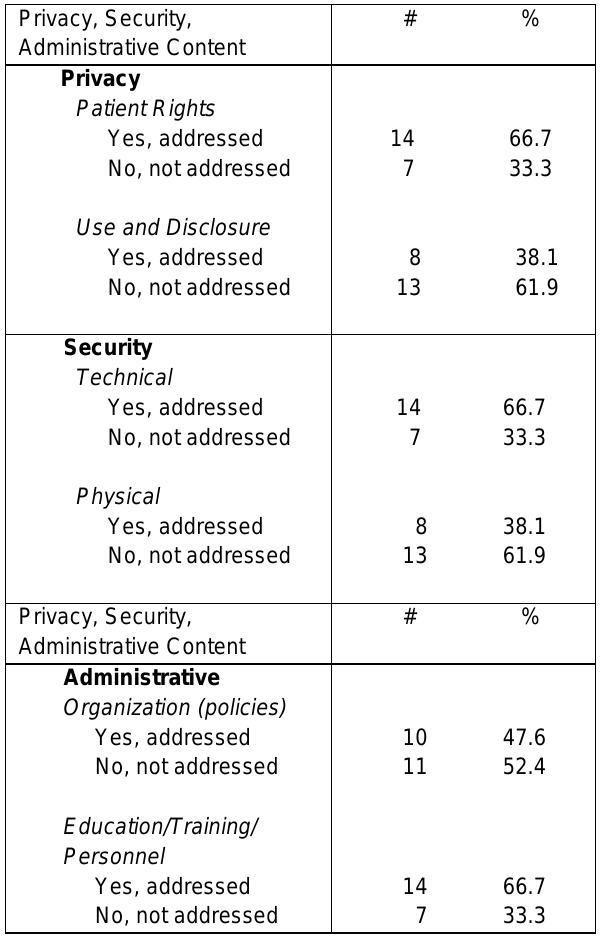
Table 2: Privacy, Security, and Administrative Content Privacy,